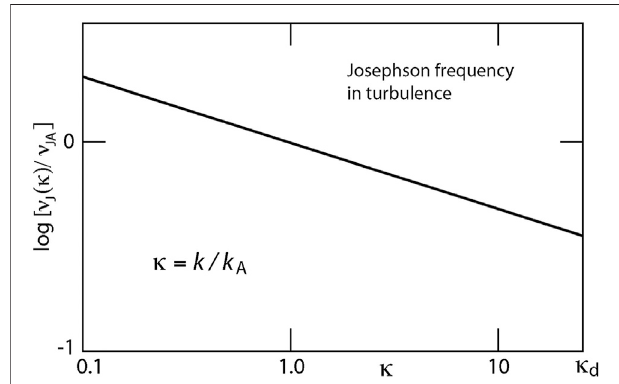
FIGURE1| Dependence of the normalized Josephson frequency in Kolmogorov turbulence on the ratio κ ≡ k / k A of turbulent wave numbers in the range 0.1 k A < k < k d under the assumption that k d λ e ≈ 1 is the ultimate dissipation scale of turbulence, which is still far above the molecular scale, caused, for instance, by spontaneous collisionless reconnection in inertial scale turbulent current fi laments, the most probable dissipation process in turbulence in collisionless plasma [cf., e.g.,